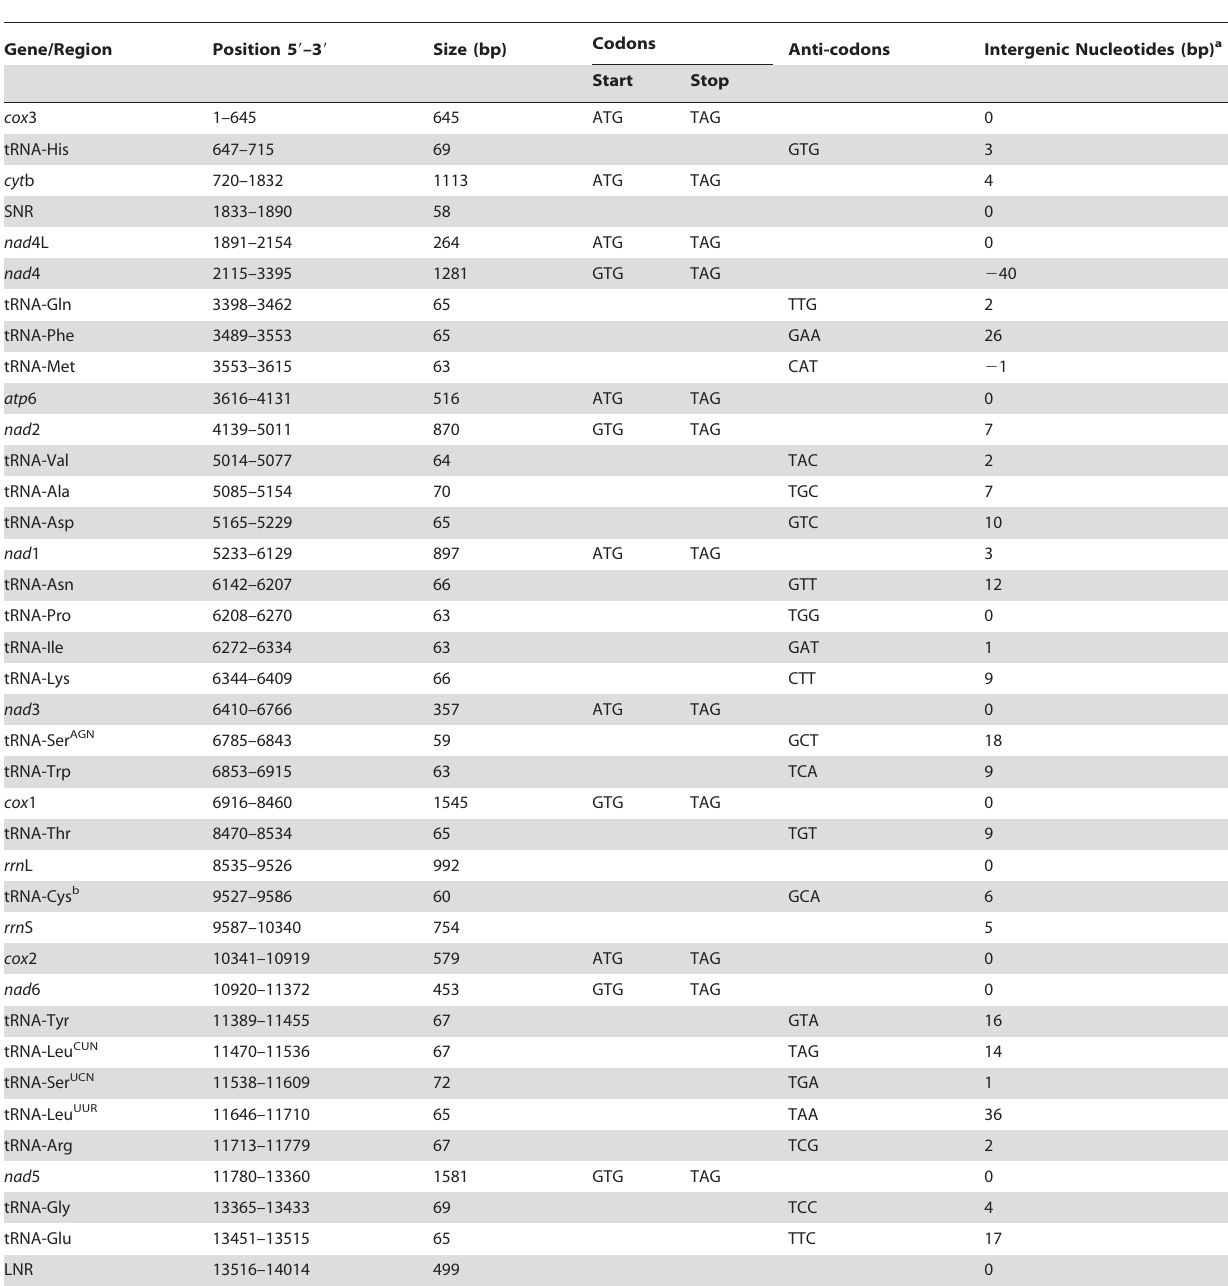
Table 3. Positions and lengths of genes and regions of P . cervi mt genome, and start and stop codons for the protein-coding genes as well as anticodons for the tRNA genes (starting from cox